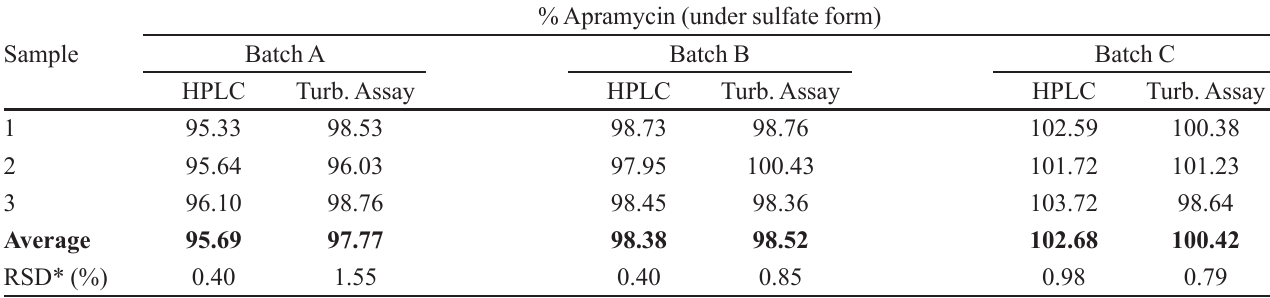
TABLE I - Results of apramycin assay obtained for the three batches of oral soluble powder by the HPLC method and by the official turbidimetric assay